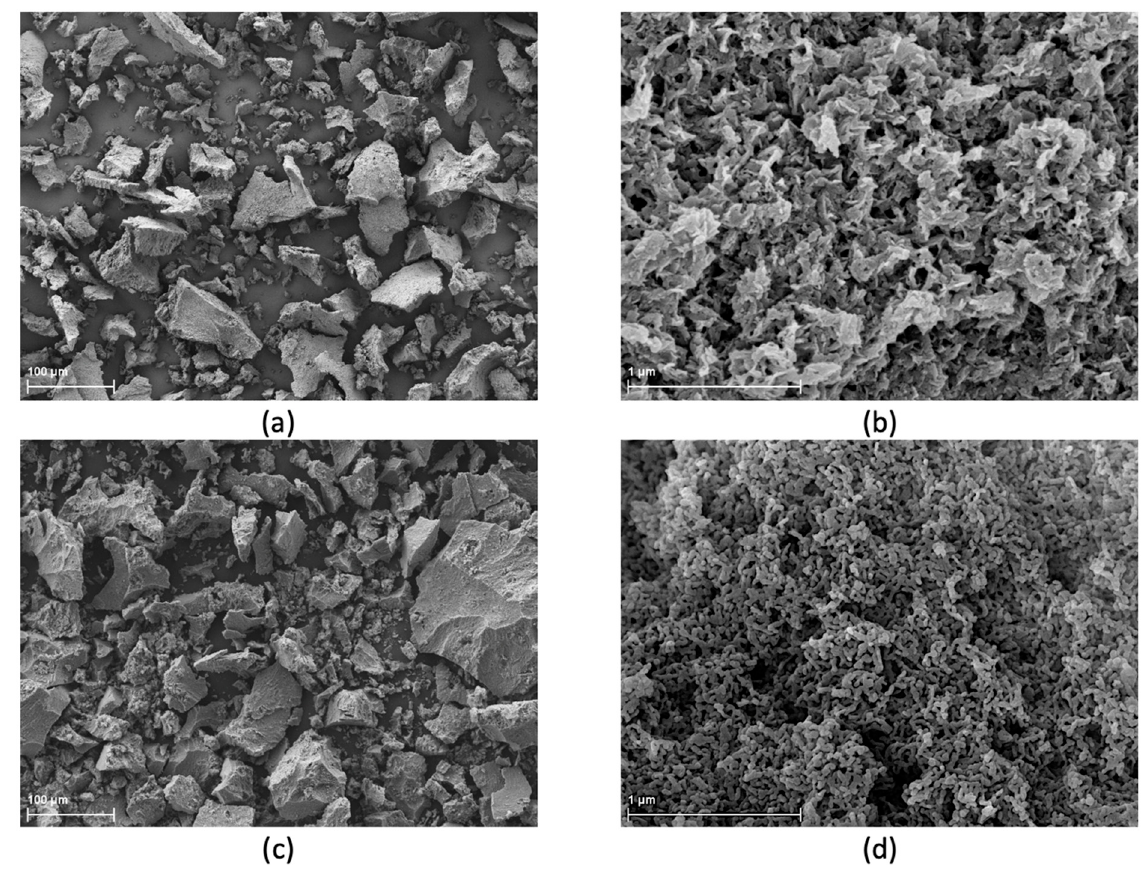
Figure 1. SEM micrographs of powder ( a , b ) raw HAP NPs, ( c , d ) heated HAP NPs.